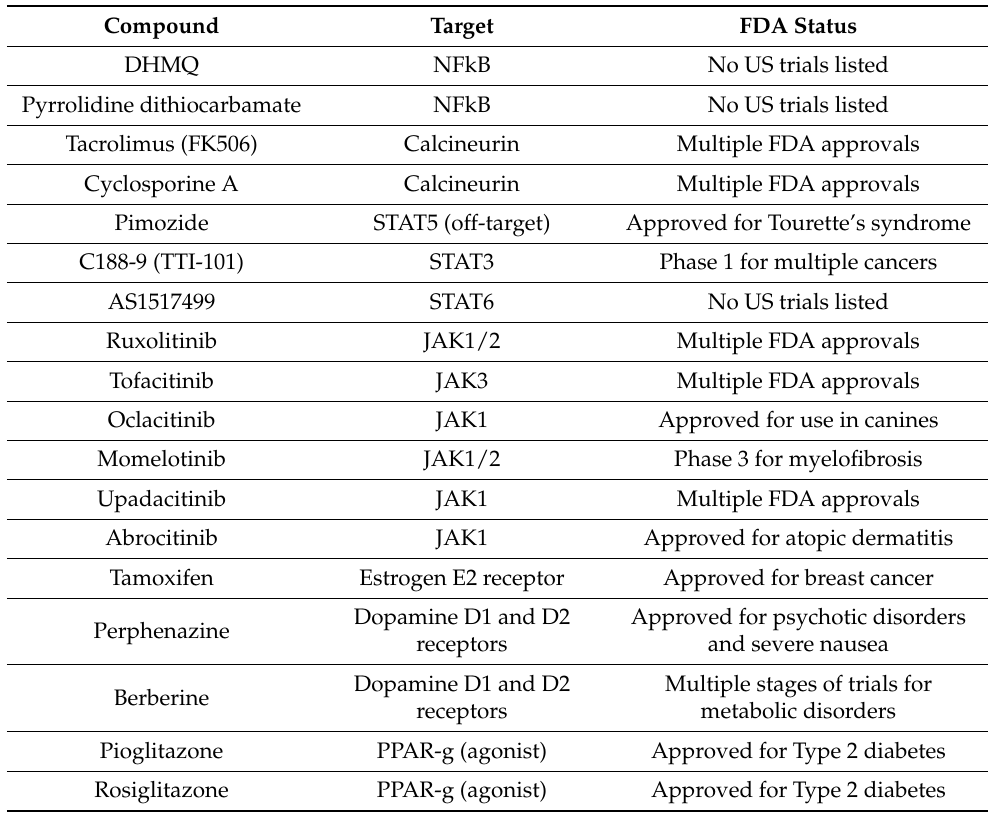
Table 3. Compounds targeting transcription factors relevant to allergic disease. All compounds are antagonists except where stated. Compound